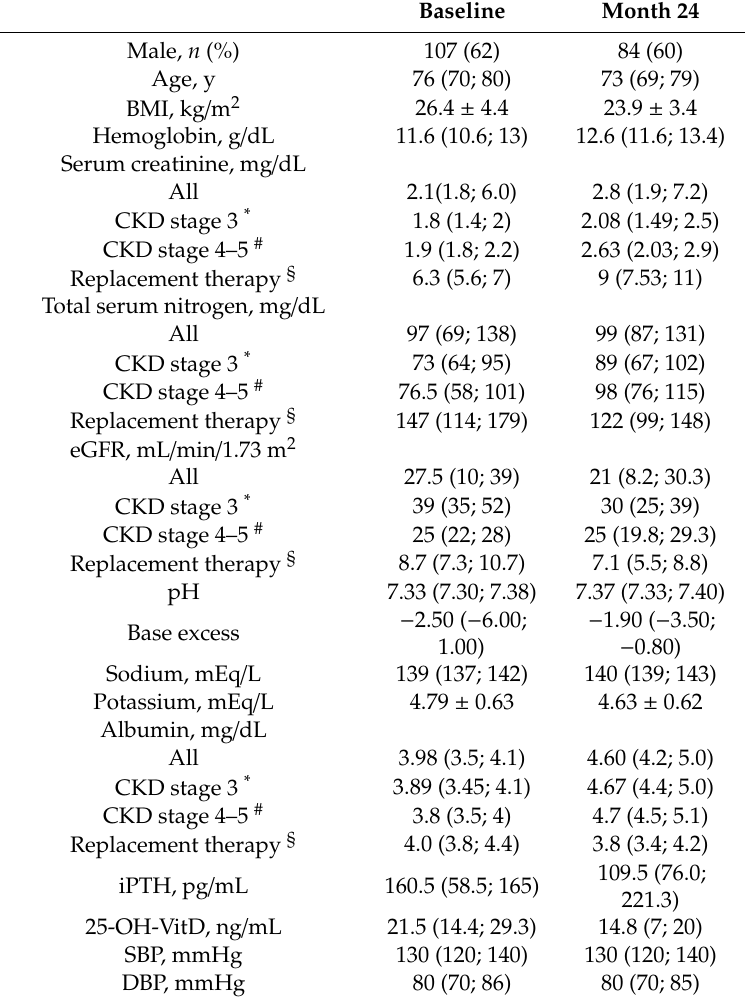
Table 1. Patient characteristics. Total patients at baseline were n = 173 and at month 24 were n =